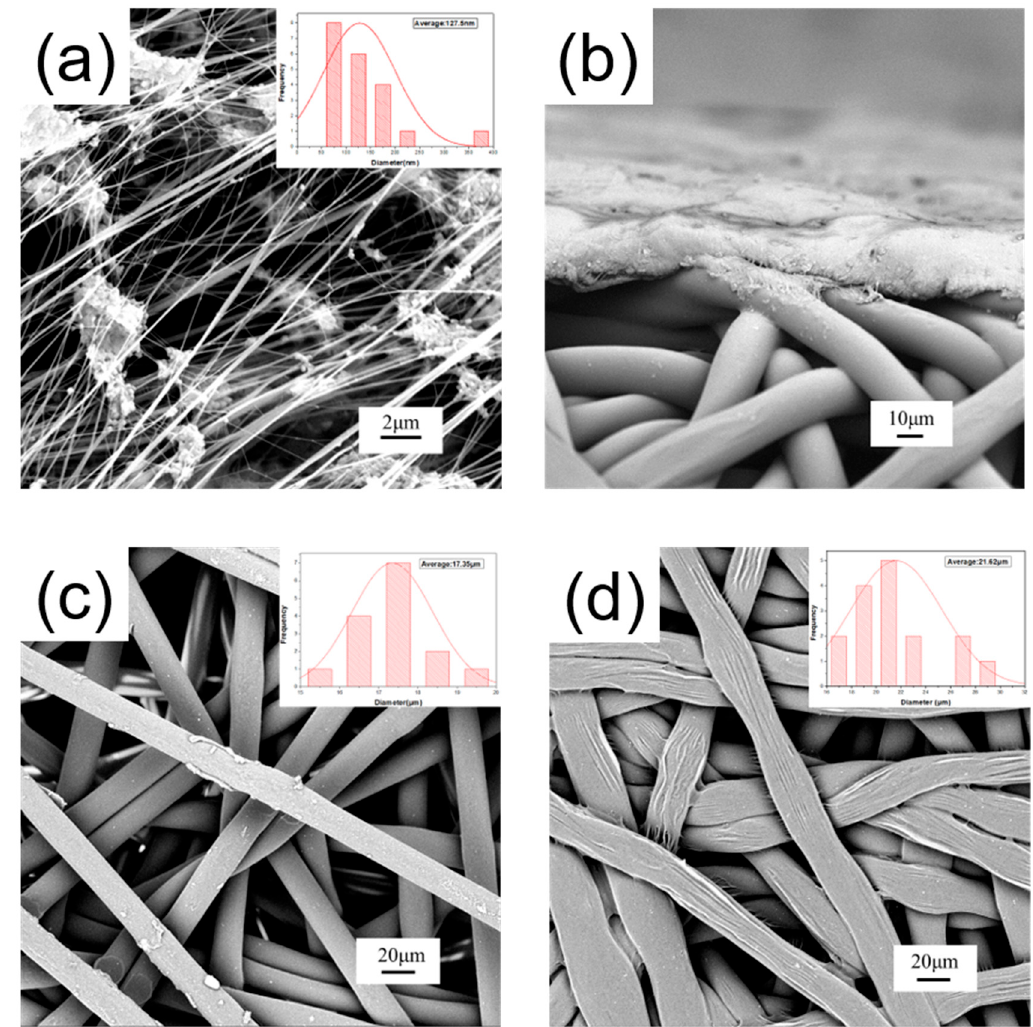
Figure 3. SEM images of electrospun CPFMs. ( a ) Nanofiber surface; ( b ) CPFMs cross profile; ( c ) micron substrate (without hot pressing); ( d ) micron substrate (after hot pressing).